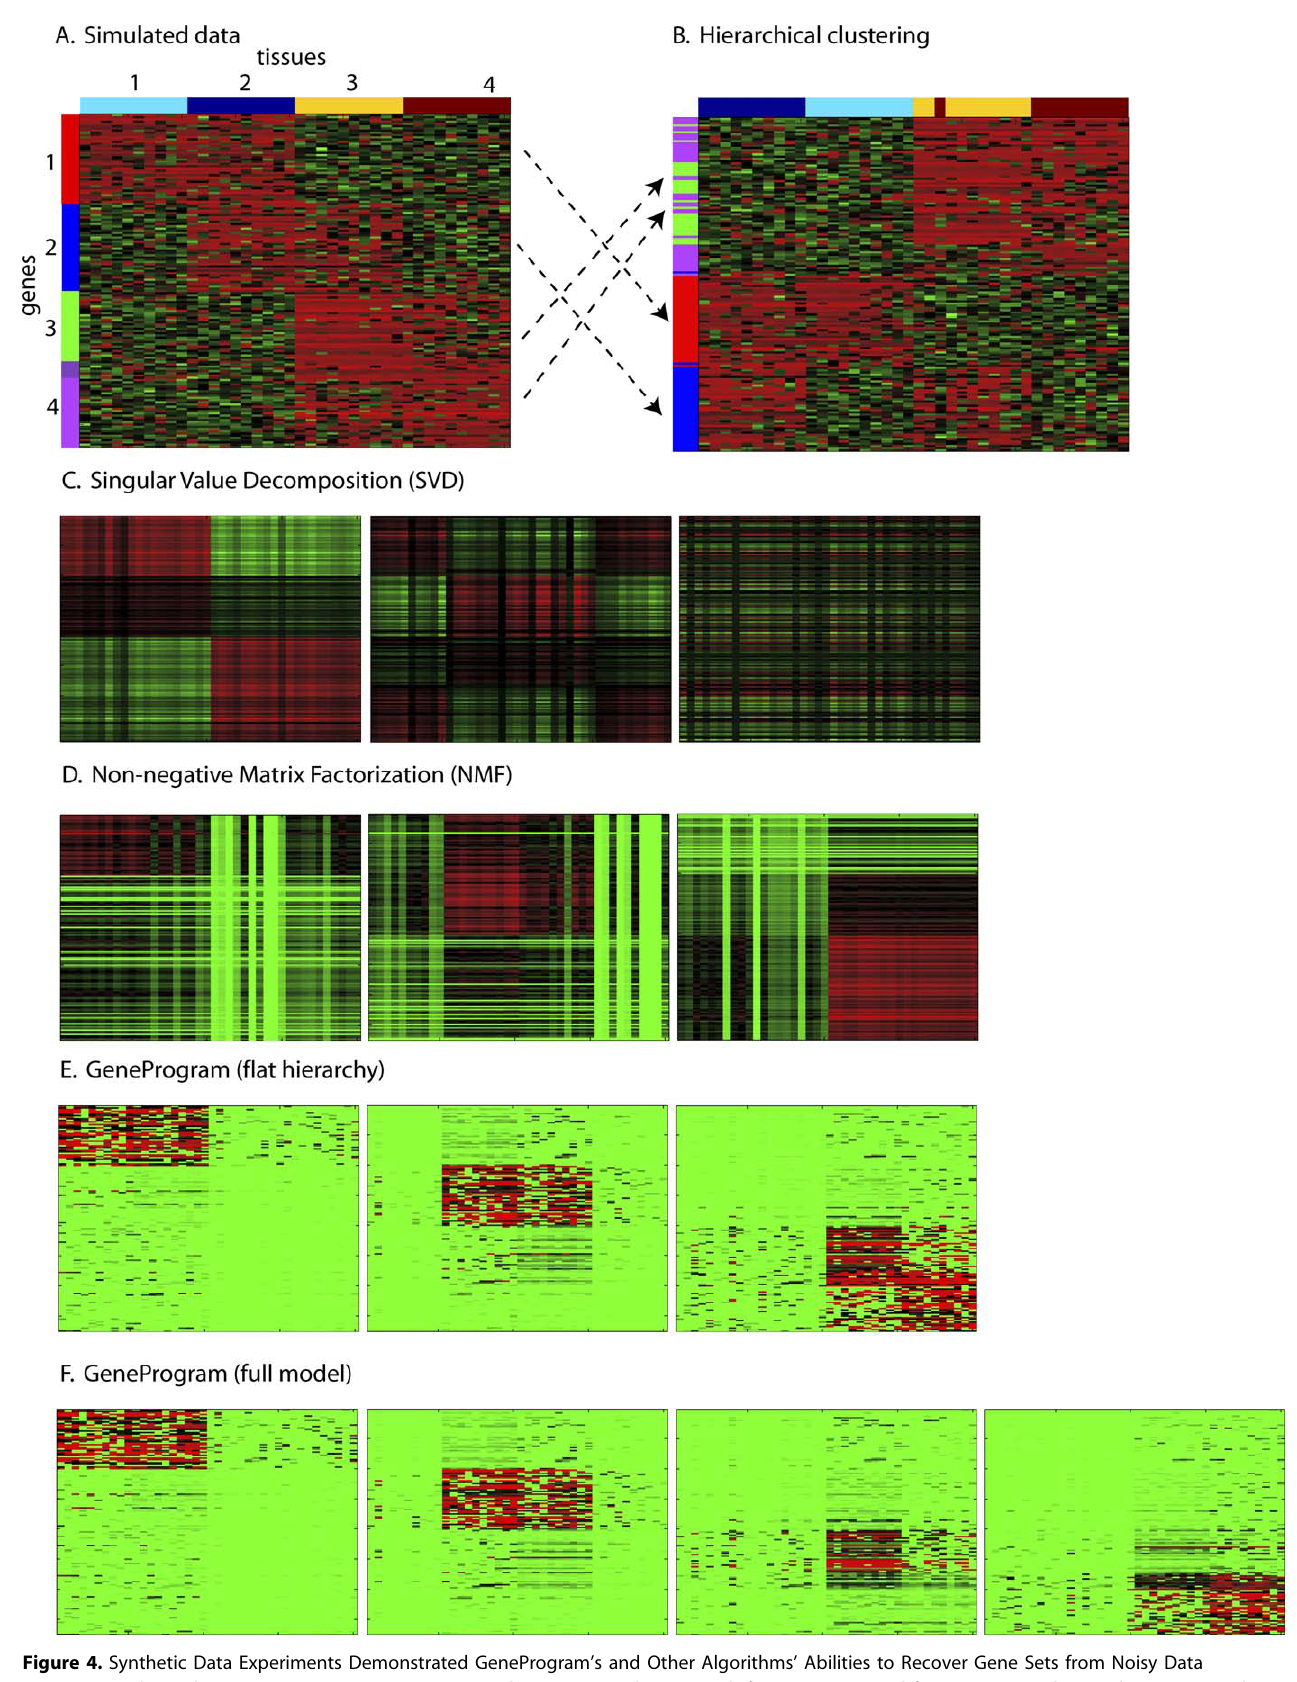
Figure 4. Synthetic Data Experiments Demonstrated GeneProgram’s and Other Algorithms’ Abilities to Recover Gene Sets from Noisy Data (A) Noisy synthetic data, containing 150 genes (rows) and 40 tissues (columns), with four gene sets and four tissue sample populations. Vertical PLoS Computational Biology |